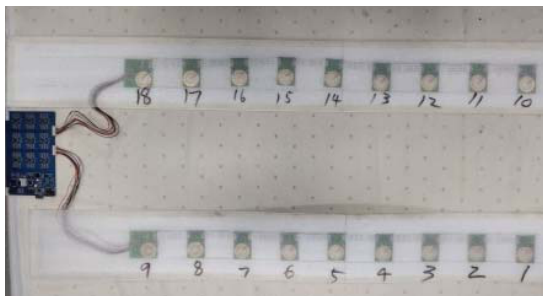
Figure 3. Piezoelectric ceramic sensors under the mattress and the embedded